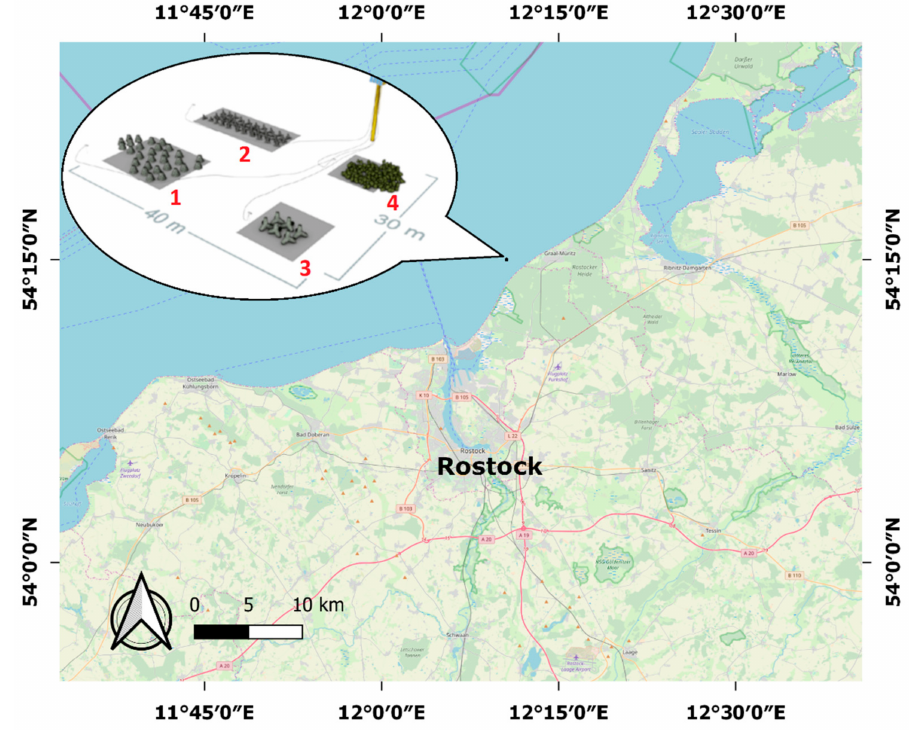
Figure 1. Location of the test object, Baltic